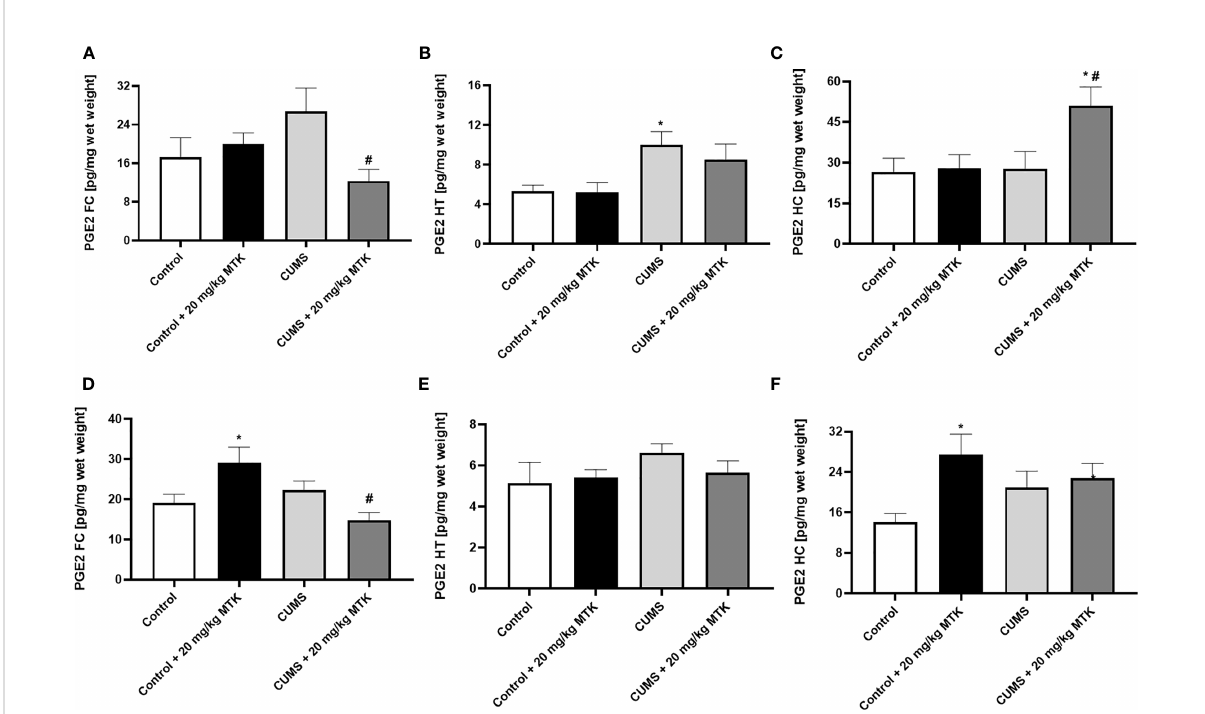
FIGURE 10 Effects of MTK on brain PGE2 level. Male (A-C) and female (D-F) rats were exposed to CUMS or control conditions for four weeks and then, while remaining under these conditions, were treated for two weeks with MTK 20 mg/kg or vehicle. PGE2 levels in FC (A, D) , HT (B, E) and HC (C, F) were determined by ELISA. Each column is the mean ± SEM of 12 to 18 rats per group. Using one-way ANOVA (with Benjamini – Hochberg False Discovery Rate), followed by Student ’ s t-test for speci fi c group comparisons: *p < 0.05 vs. Control + DMSO; #p < 0.05 vs. CUMS +